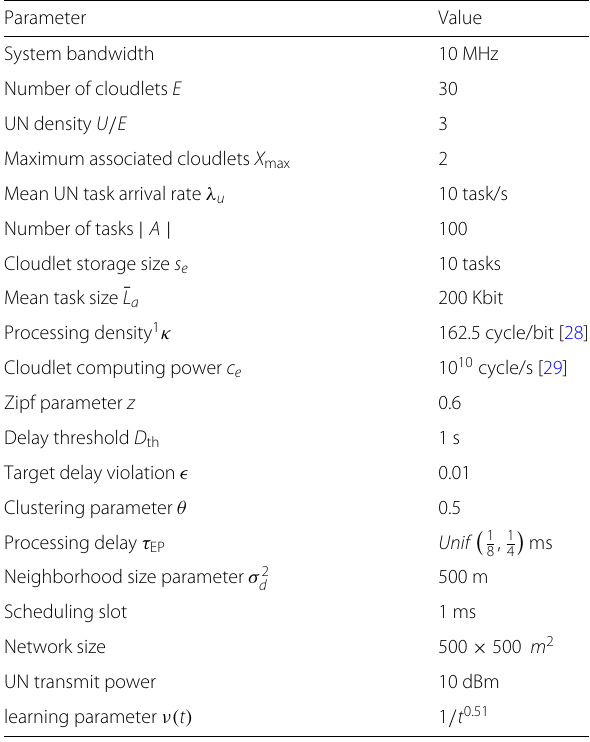
Table 2 Simulation